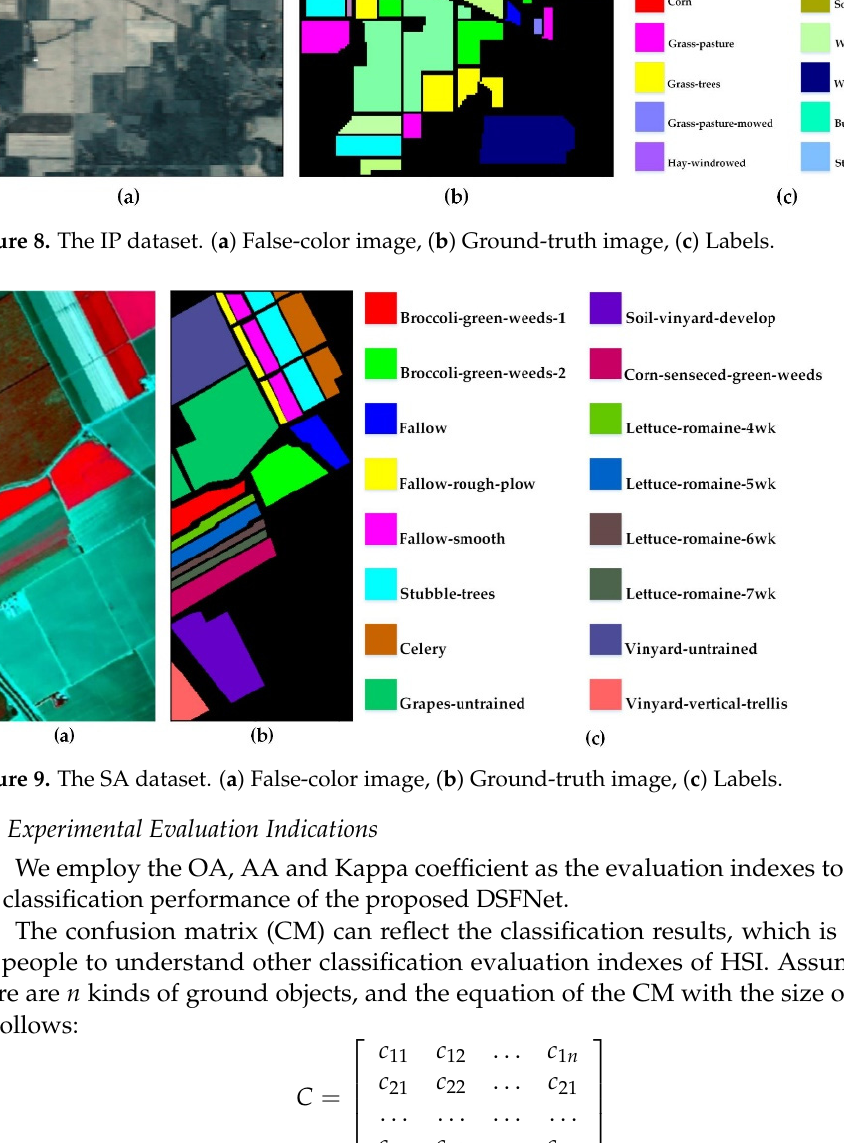
Figure 7. The UP dataset. ( a ) False-color image, ( b ) Ground-truth image, ( c ) Labels.